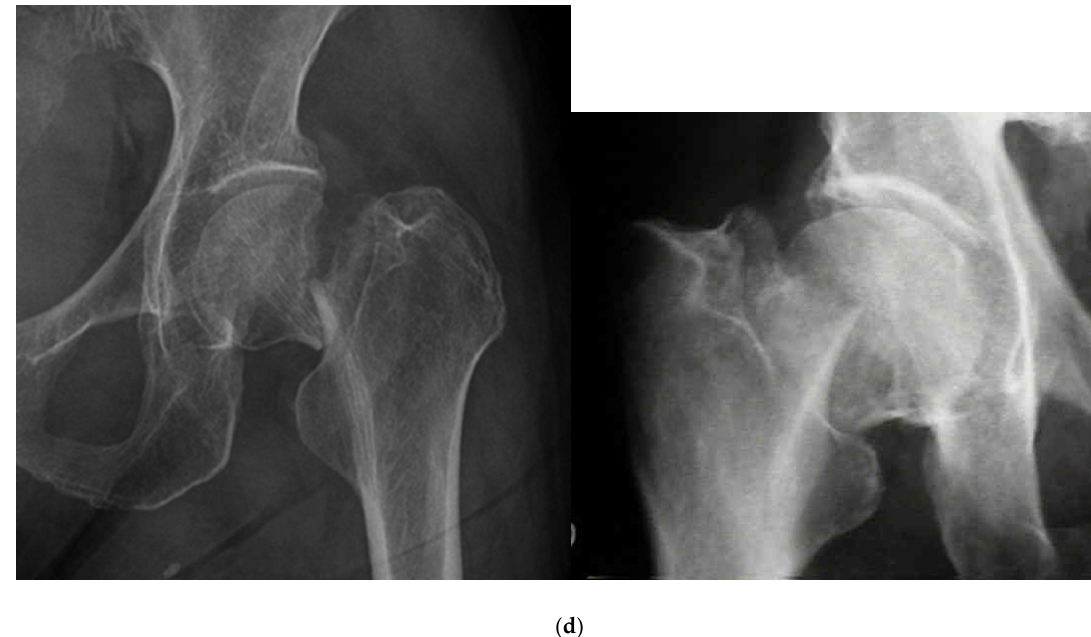
Figure 1. Example radiographs demonstrating Garden classification: ( a ) Garden I; ( b ) Garden II; ( c ) Garden III; ( d ) Garden IV.